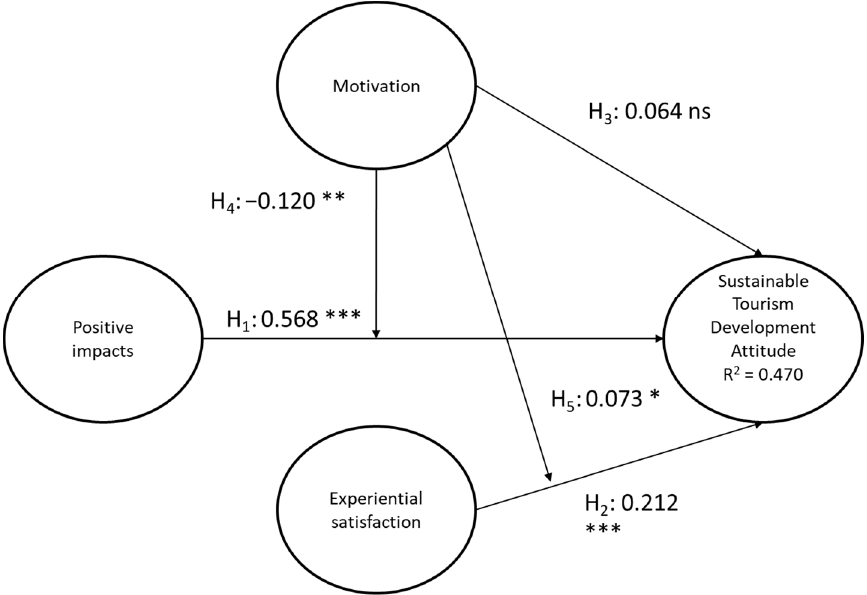
Figure 2. Structural model.